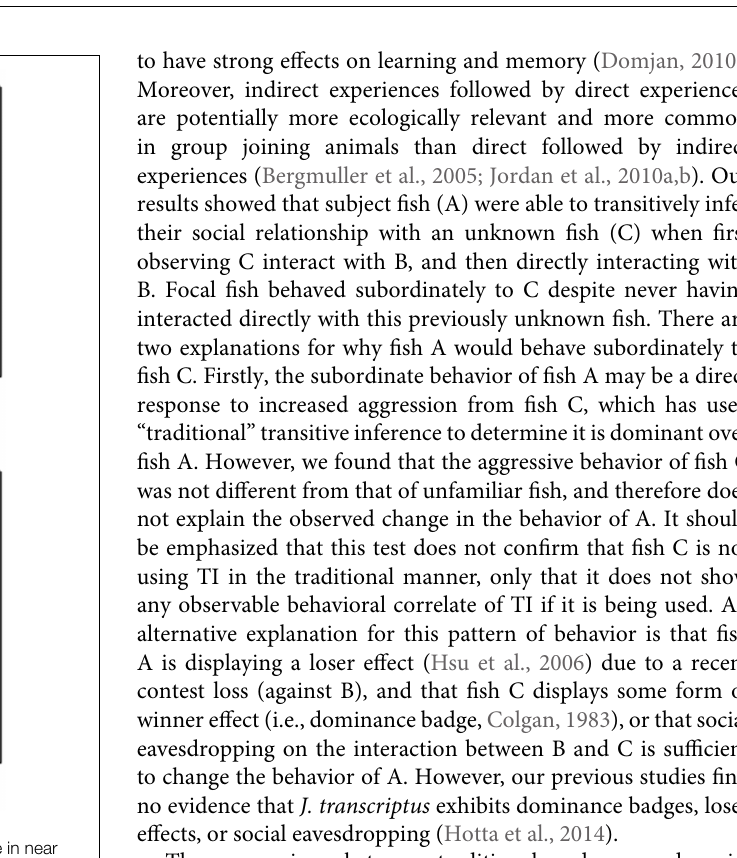
FIGURE 2 | Results of experiment. (A) rushing time and (B) time in near zone of A and C in test phase. * p < 0 . 01 , ** p < 0 . 005